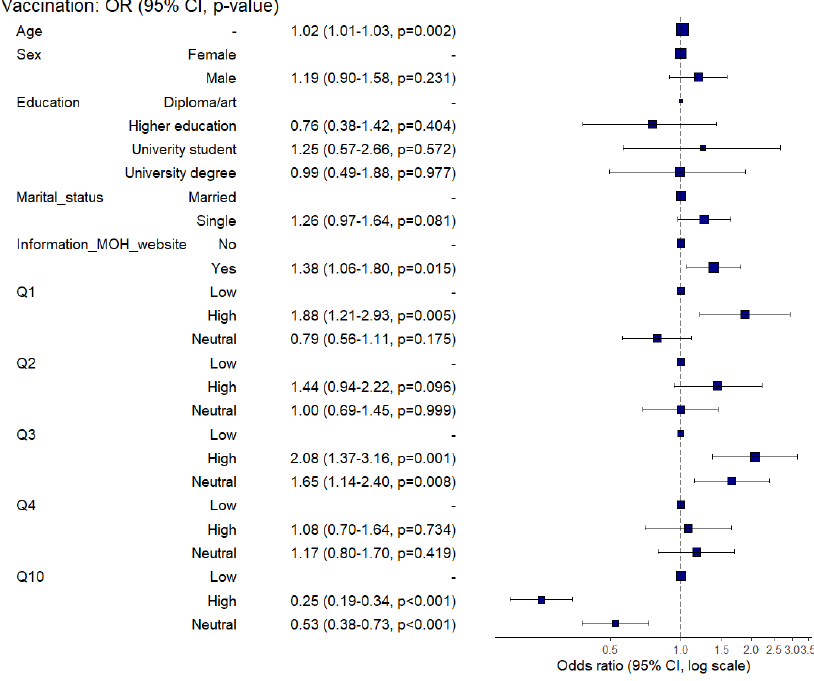
Figure 4. Forest plot of the adjusted odds ratio s; the dependent factor is vaccine